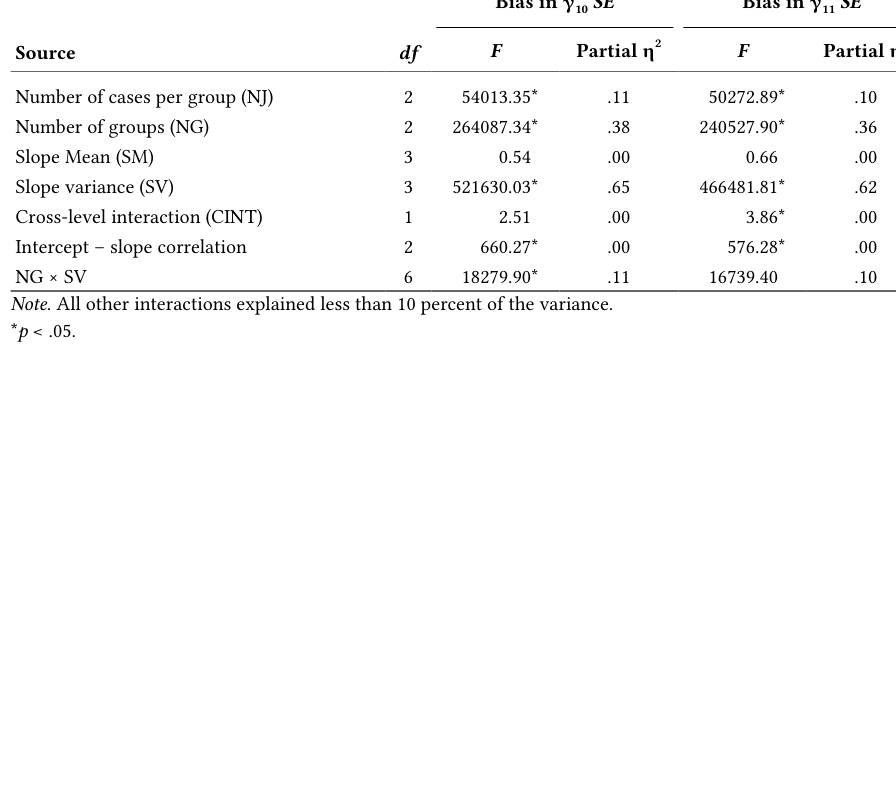
Between Subjects ANOVA for Bias in the Standard Errors for γ 10 and γ 11 From Study 1 Source df Number of cases per group (NJ) 2 54013.35* Number of groups (NG)